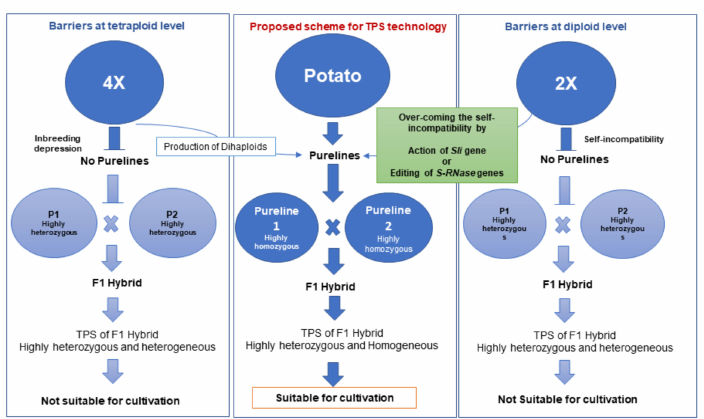
Figure 1. Molecular approaches to overcome self-incompatibility in diploid potatoes. Self- incompatibility barriers at the diploid level can be overcome by the action of the Sli gene or by editing the S-locus ( S-RNase )